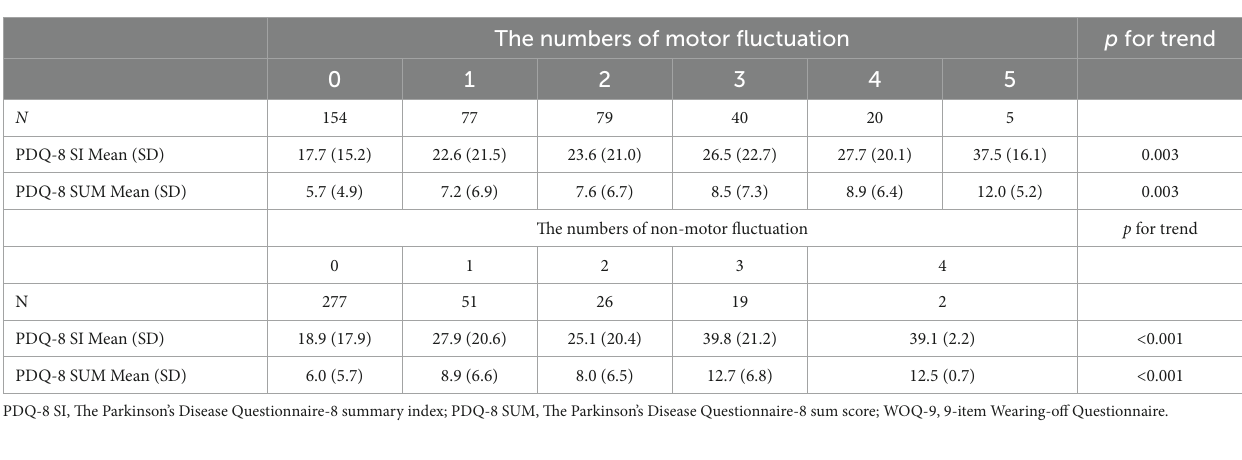
TABLE 3 Relationship between the scores of PDQ-8 SUM/PDQ-8 SI and the number of motor fluctuations; relationship between the scores of PDQ-8 SUM/ PDQ-8 SI and the number of non-motor fluctuations.